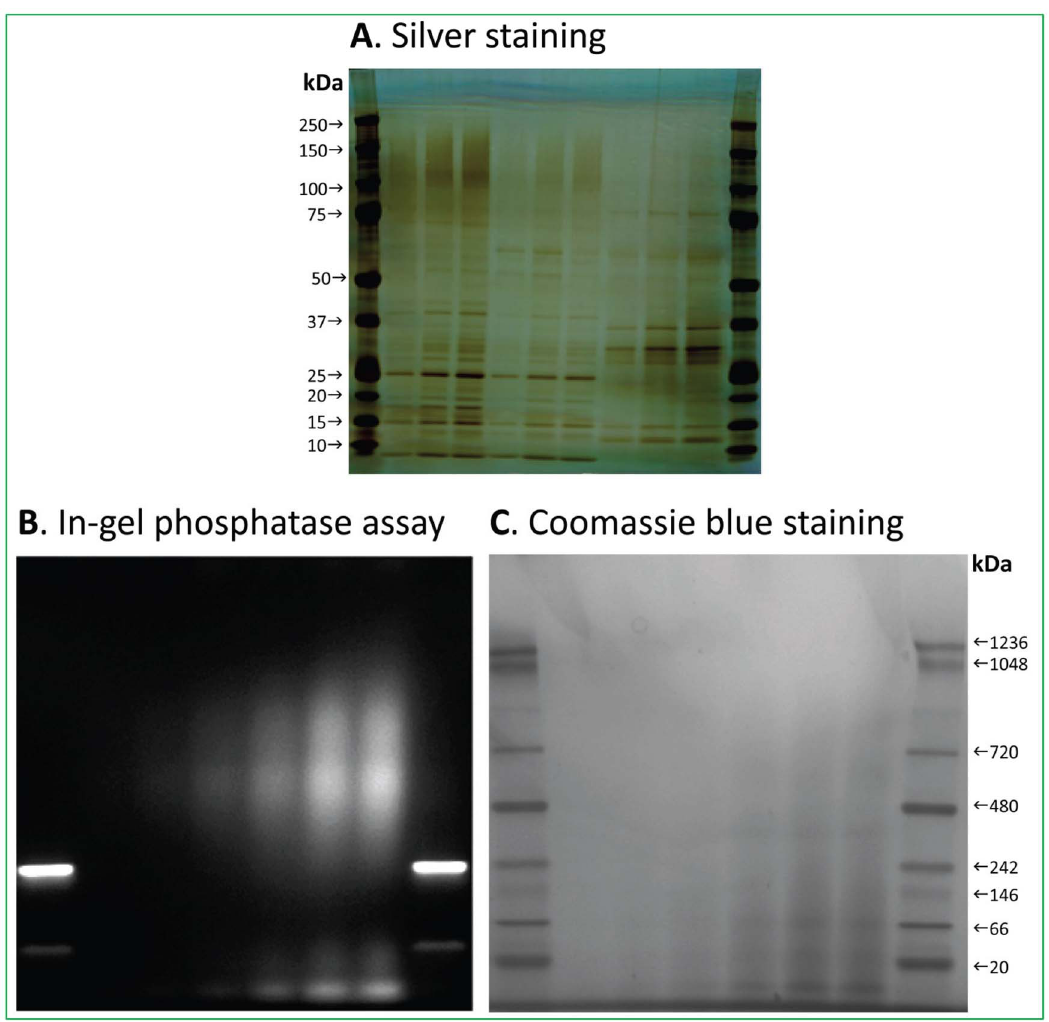
Figure 8. SDS-PAGE and native gel analysis of protein composition and PAP activity. (A) Denaturing gel analysis of the purified PAP fractions from Affigel Blue column by SDS-PAGE and stained by silver nitrate. Lanes 1 and 11, Bio-Rad Precision plus protein standards; lanes 2–4, 0.28, 0.55 and 0.83 m g of fraction # 4; lanes 5–7, 0.19, 0.37 and 0.56 m g of fraction # 5; lanes 8–10, 0.30, 0.60 and 0.90 m g of the pooled fractions 11–17. (B) PAP activity determined by in-gel phosphatase assay with DiFMUP. Lanes 1 and 8, positive control B-phycoerythrin; lanes 2–7, 0.5, 1, 3, 6, 10 and 12 m g of PAP from the pooled fraction. (C) Native gel analysis of the purified PAP fractions stained with Coomassie Blue. Lanes 1 and 8, native marker unstained protein standards; lanes 2–7, 0.5, 1, 3, 6, 10 and 12 m g of PAP from the pooled